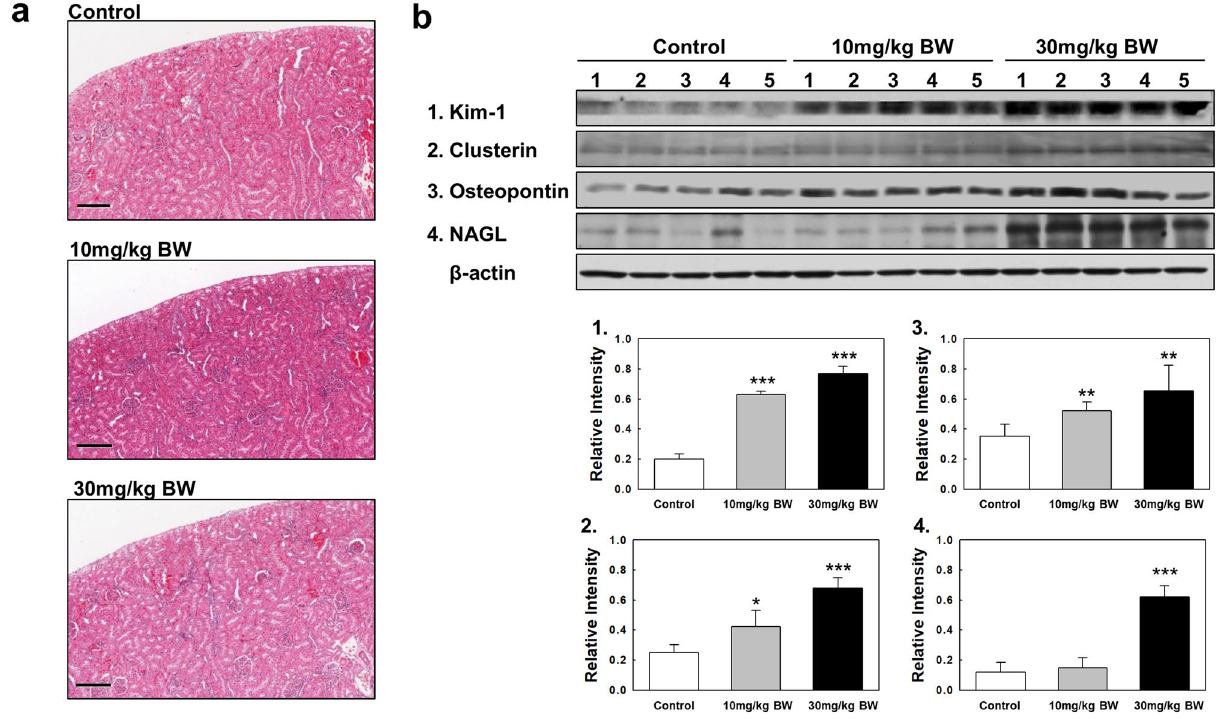
Figure 1. Histopathological observations and determination of kidney injury biomarkers using Western blot analysis. ( a ) Histopathological observations in kidneys. Kidney tissues were fixed in 10% formalin and then embedded in paraffin. Tissue slides of 5-μm-thick sections were stained with hematoxylin and eosin and then observed by light microscopy (scale bar = 200 μm; magnification, × 100). Control group (0.5% carboxymethyl cellulose as vehicle only), 10 mg/kg BW TAA, 30 mg/kg BW TAA. ( b ) Western blot analysis of Kim-1, NGAL, osteopontin, and clusterin proteins in rat kidney tissue. (1) Kim-1, (2) NGAL, (3) osteopontin, and (4) clusterin. Original blots are presented in Supplementary Western blot data. Quantities represented by the gel bands are expressed as intensity relative to β-actin. All relative intensity results are presented as the means ± SD of five experiments. *, **, and *** indicate p -values of 0.05, 0.01 and 0.001, respectively compared to the